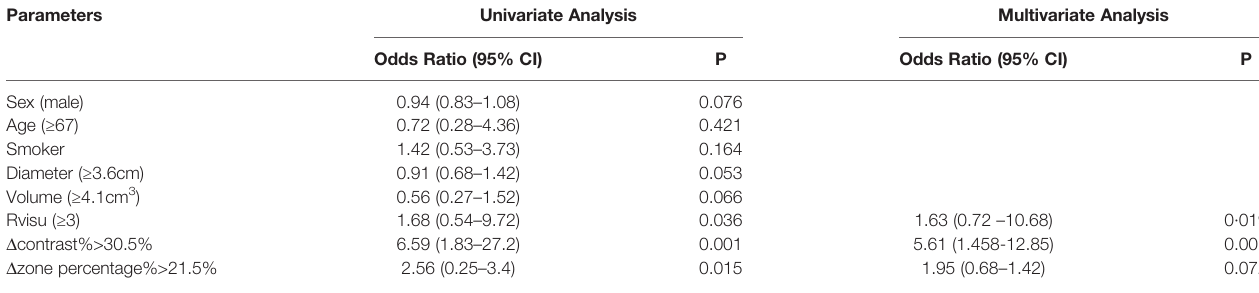
TABLE 4 | Results of Uni- and multi-variate analyses for predictors of LTP in 50 patients. Parameters Univariate Analysis Multivariate Analysis Odds Ratio (95% CI)